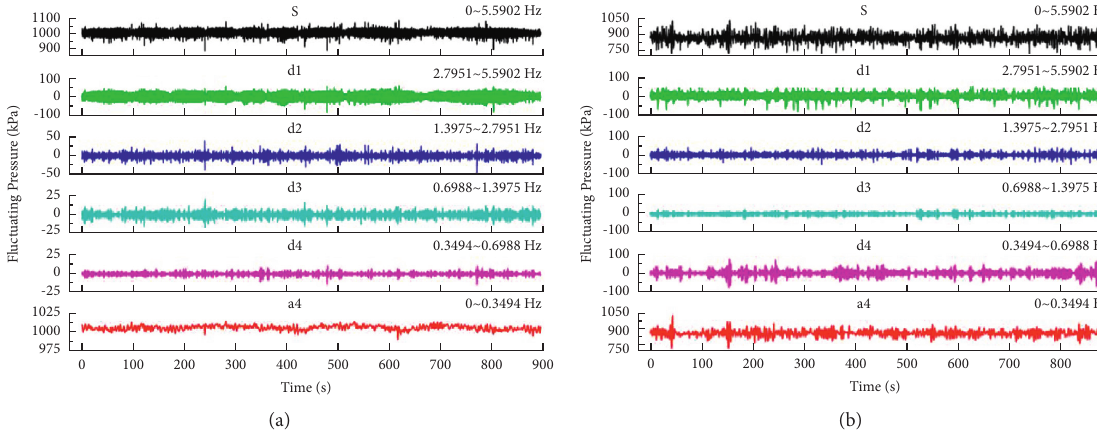
Figure 5: Fluctuating pressures time history curves at No.17 and No.40 measuring points. (a) No.17 measuring point. (b) No.40 measuring Table 2: Variance and proportion of fluctuating pressures in each frequency band. Frequency band Frequency range